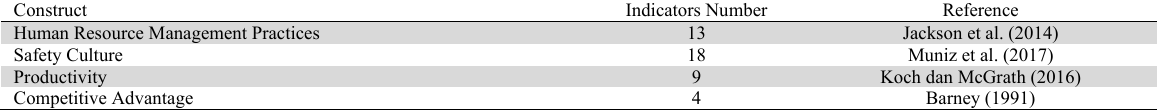
Number of indicators and reference sources for construct